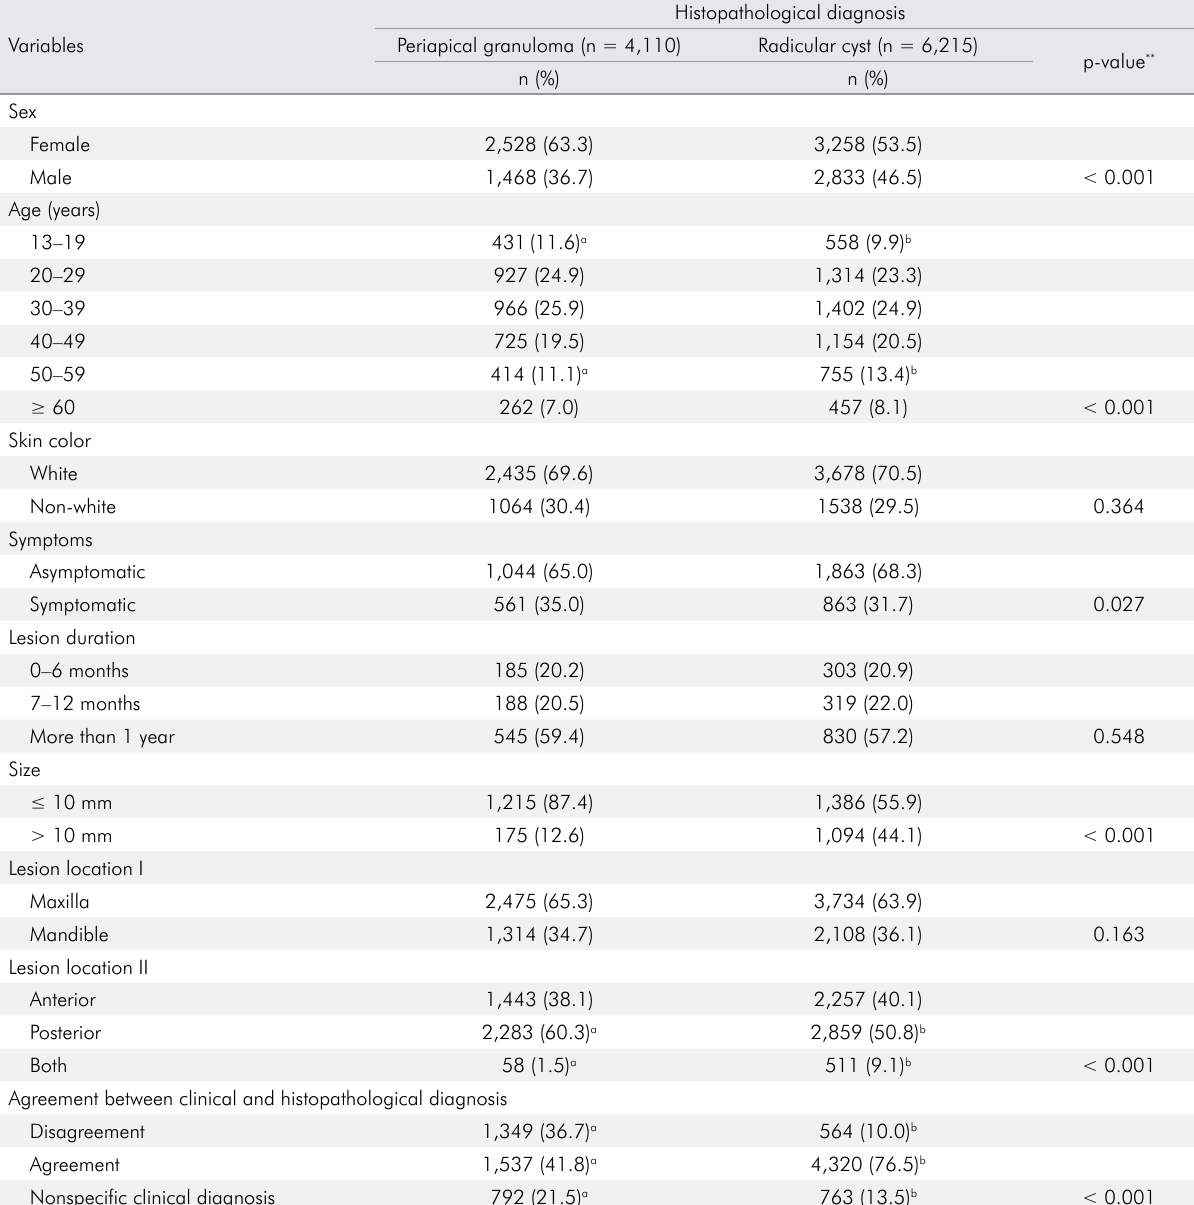
Histopathological